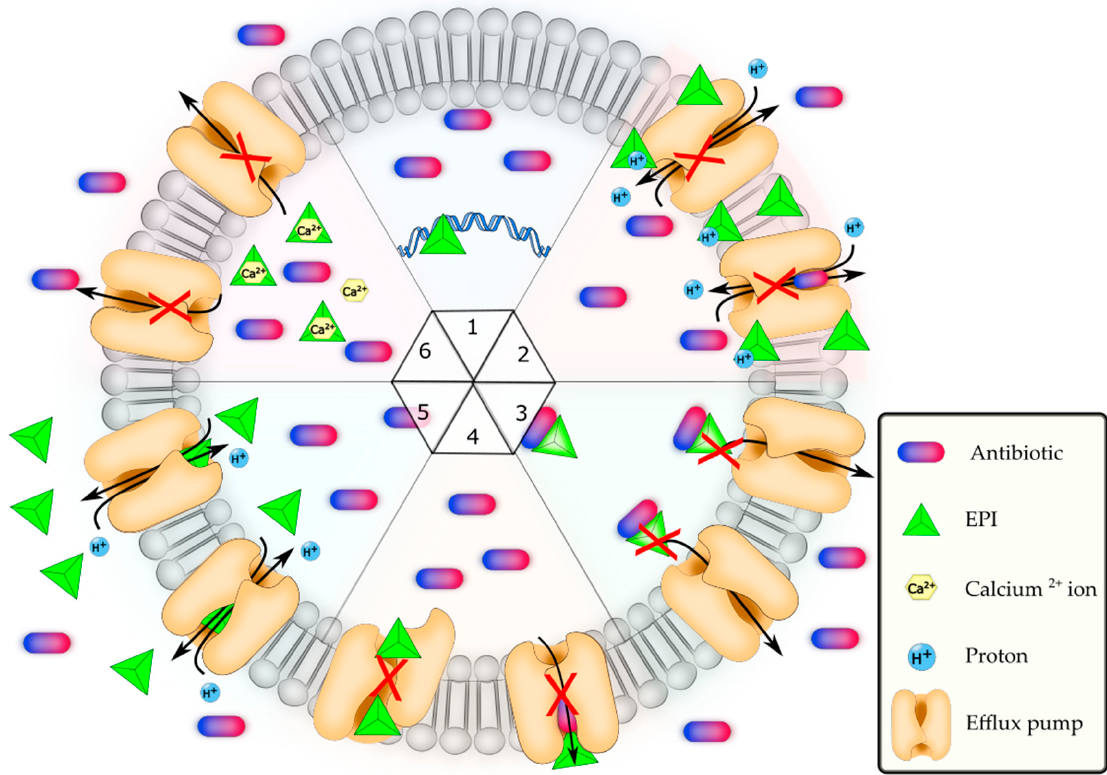
Figure 3. Modulation of MFS efflux pump by efflux pump inhibitors (EPIs) in S. aureus . 1: Downregulation of genes encoding an efflux pump. 2: Disruption of the membrane potential. 3: Interaction of EPIS with antimicrobials. 4: Disruption and impediment of efflux pump assemblies and membrane-bound proteins. 5: Competitive and non-competitive inhibition by EPIs. 6: Chelation of Ca 2+ ions by EPIs in some specific efflux pumps, such as LmrS of S. aureus [117].